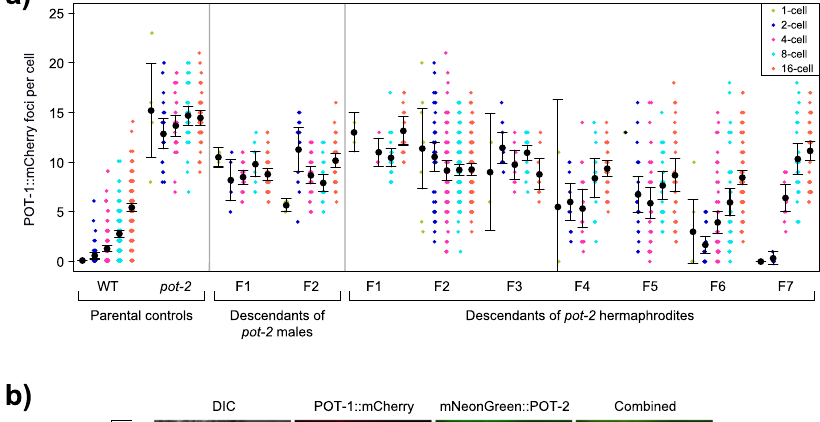
periphery 47 (Fig. 3b and Supplementary Fig. 3a, ANOVA p < 10 − 8 H3K23 methyltransferase that promotes transgenerational silen- for each). In contrast, an increase in Pot1 foci was observed for cing responses to small RNAs, results in progeny with very low 1- and 2-cell F2 embryos of hermaphrodites de fi cient for JMJD-2, levels of Pot1 foci (Fig. 3b, ANOVA p < 10 − 8 ) 47,50,51 . To further con fi rm our results, we analyzed a pot-1::mCherry a demethylase that targets H3K9 or H3K36 (Fig. 3b, ANOVA strain that was homozygous mutant for the small RNA biogenesis p < 10 − 15 ) 48,49 . We also observed that de fi ciency for SET-32, an COMMUNICATIONS BIOLOGY| (2021) 4:158 |https://doi.org/10.1038/s42003-020-01624-7|www.nature.com/commsbio